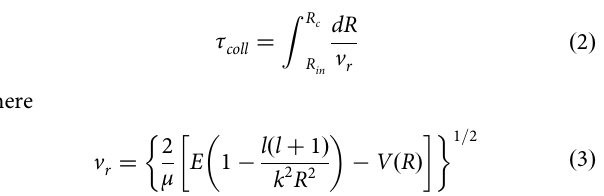
Fig. 3 Effects of the centrifugal component of the interaction on Ne * + Ar, N 2 , NH 3 CHEMI. The turning point ( R c ) dependence on the impact parameter b , or, in quantum picture on ‘ , evaluated for the four systems (Ne * + NH electronic ground state ions ( b ), Ne * + Ar ( c ) and Ne * + N 2 ( d ) at fi ve E coll values (see text). The ket indicates the selected atomic state of Ne * ( 3 P 0 )